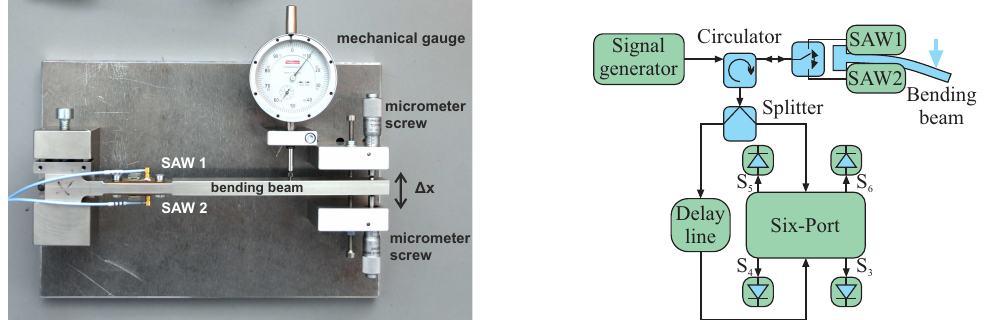
Figure 15. Photo and schematic of the measurement setup with a mechanical bending beam featuring two surface acoustic wave (SAW) resonators in a differential configuration.